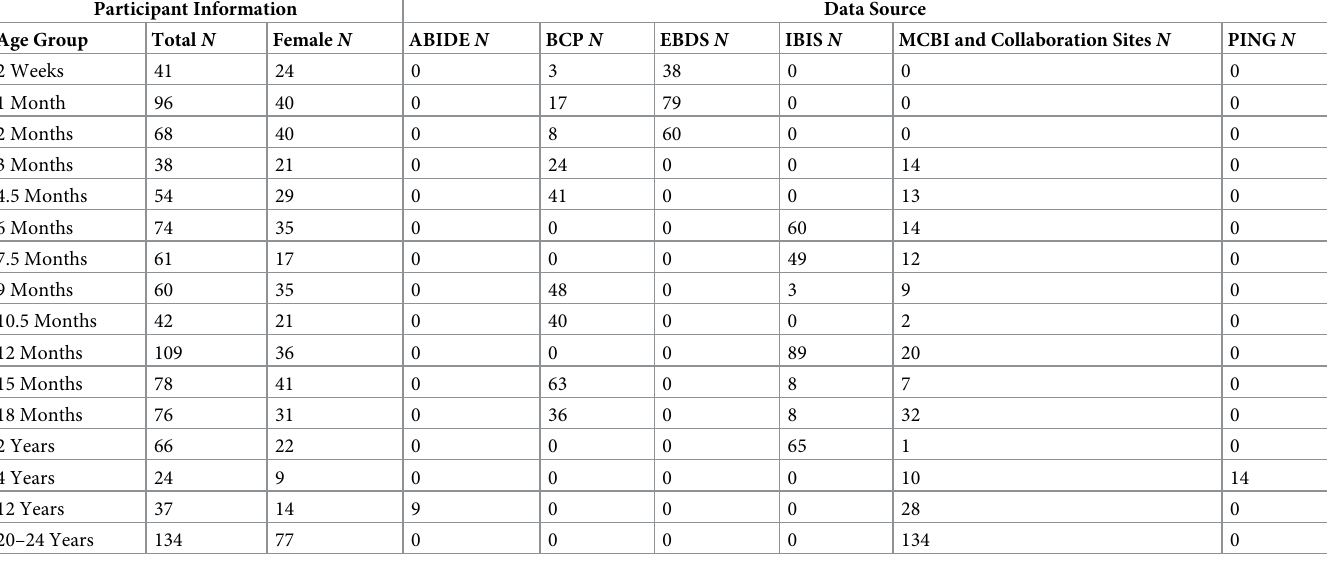
Table 1. Demographical information of study participants by age group, sex, and data source. Participant